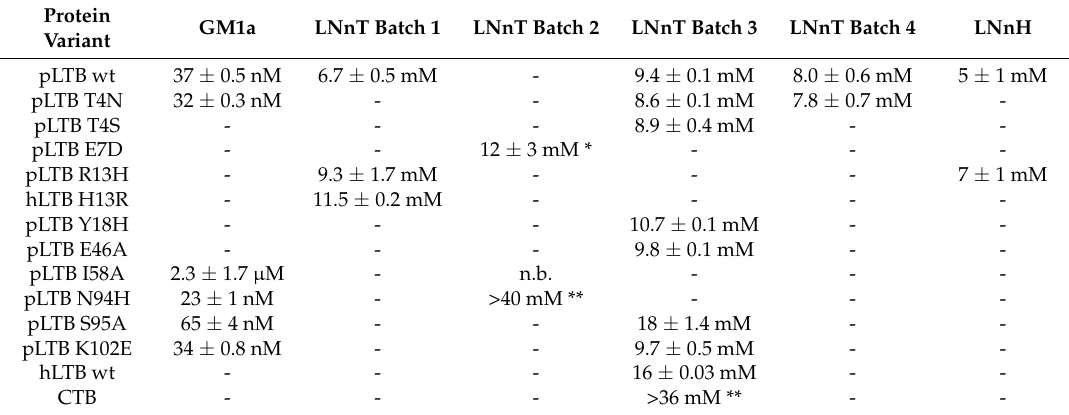
Table 1. K D values measured by SPR, grouped by analyte and batch